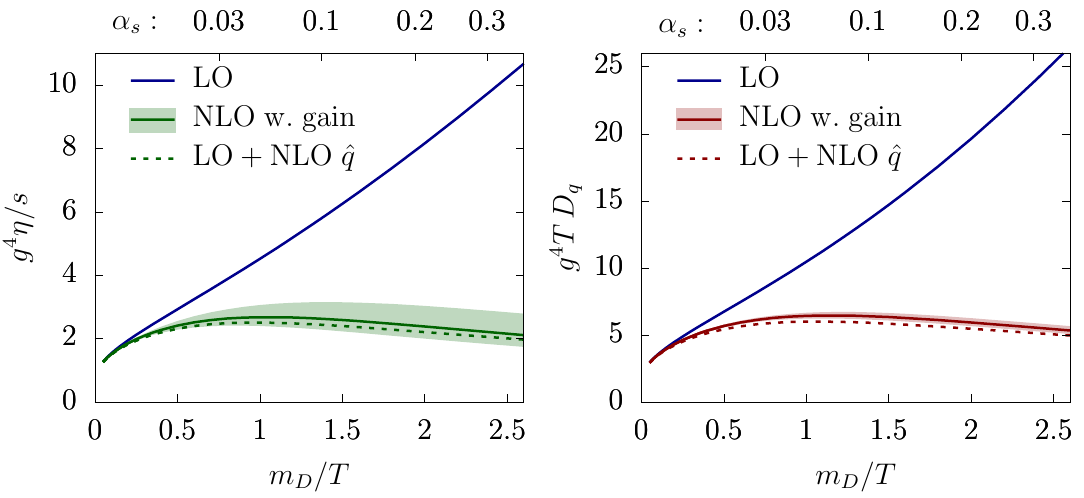
Figure 6 . (a) The shear viscosity to entropy ratio (cid:17)=s , and (b) the baryon number di(cid:11)usion coe(cid:14)cient D q (times temperature) normalized by the leading 1 =g 4 as a function of m with N f = 3 light (cid:13)avors. (The corresponding value of (cid:11) s is shown on the upper horizontal